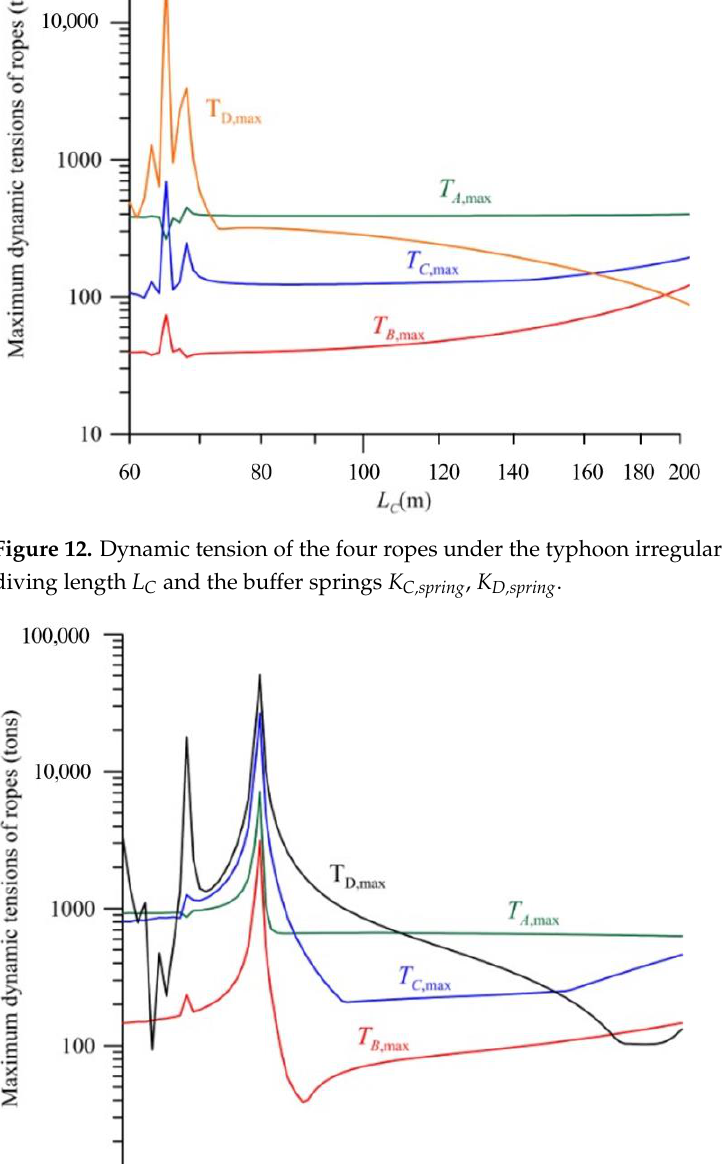
Figure 13. Dynamic tension of the four ropes under the typhoon irregular wave as a function of the cross-sectional area of the two pontoons A BX , A PX and the diving depth of the floating platform L C